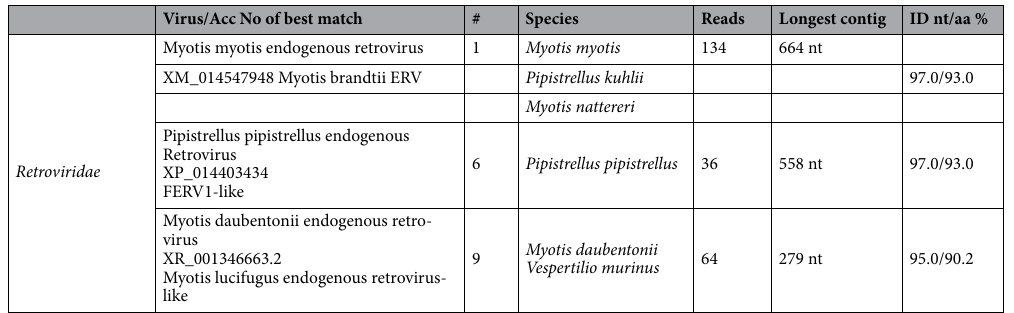
Table 3. Virus results per virus family. Acc No, Accession number; #, Pool number; ID nt/aa, Identity nucleic acid/amino acid; nt, nucleotides. –, no homology was found.